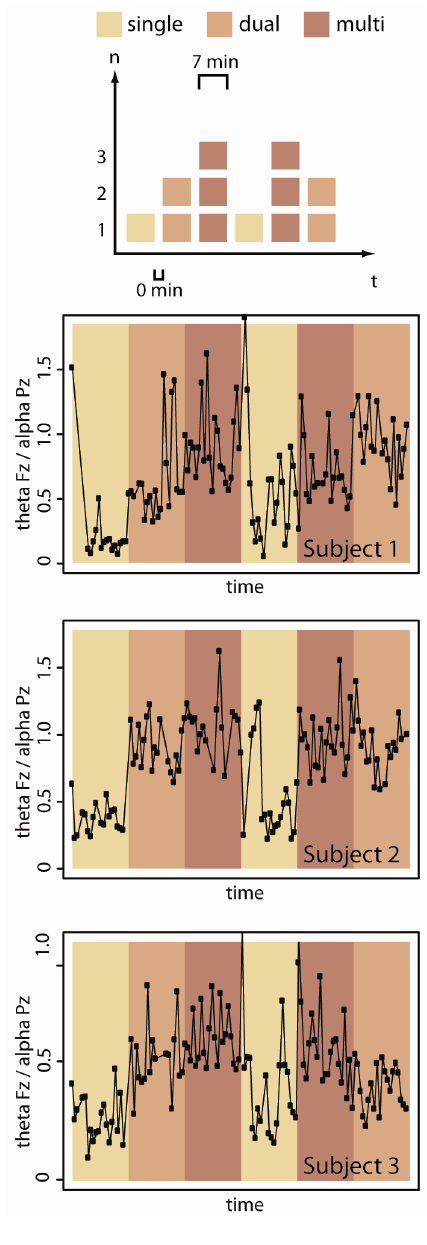
FIGURE 5. Examples of reactivity of the theta Fz/alpha Pz ratio to continuous changes in task demands. Task setting: the subjects performed the single, dual, and multi conditions continuously, 7 min per condition, for a total time of 42 min. The value is averaged over 20 sec. The change between single compared to dual and multi was clear, but between dual and multi at the individual level varied somewhat more (clear in subjects 2 and 3, but not in 1). The fluctuating attention and/or effort of the subject may affect the